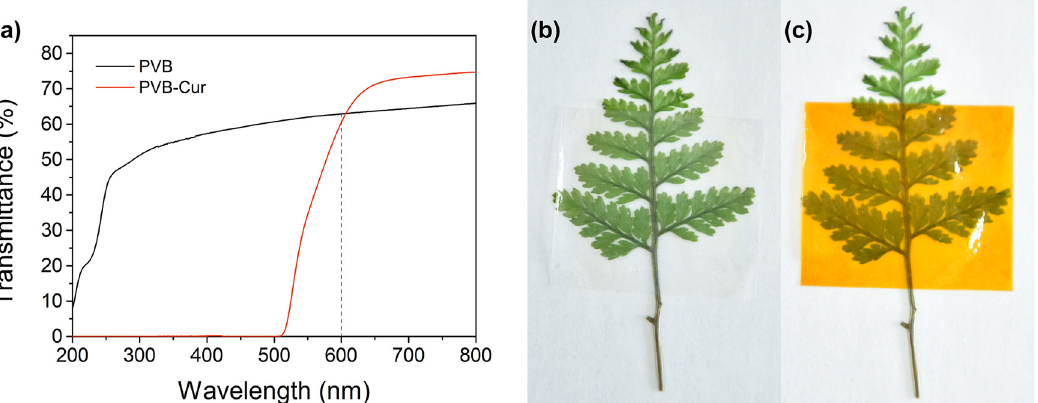
Figure 3: Light transmittance characteristics of PVB and PVB – Cur fi lms. ( a ) PVB fi lm under visible light and ( b ) PVB – Cur fi lm under visible light ( c )